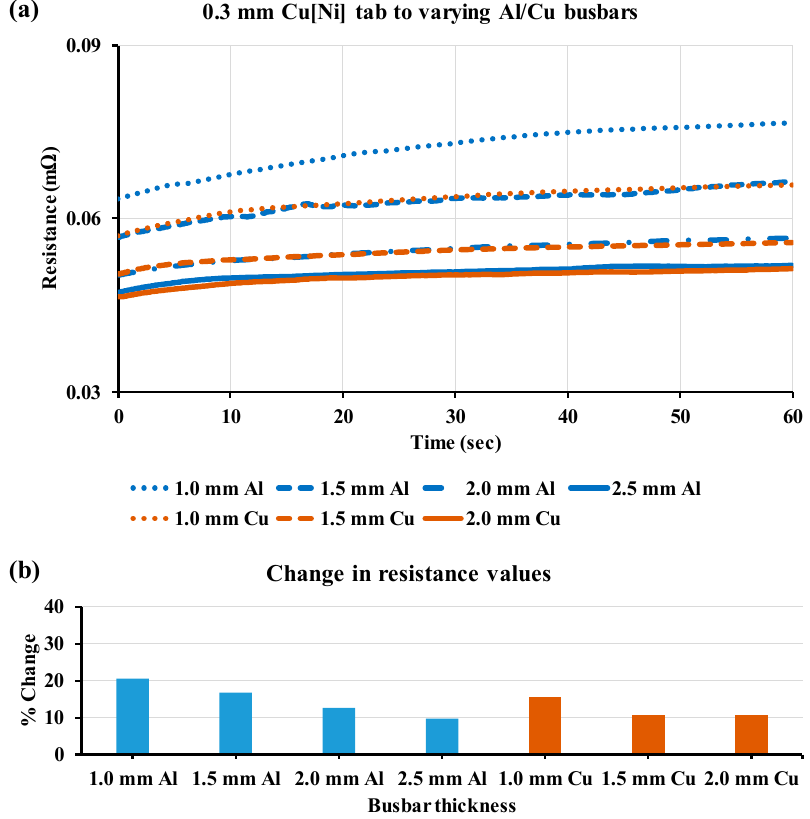
Figure 5. ( a ) Electrical resistance profiles for 0.3 mm Cu[Ni] tab to Al / Cu busbars; and ( b ) the percentage (%) changes in resistance.